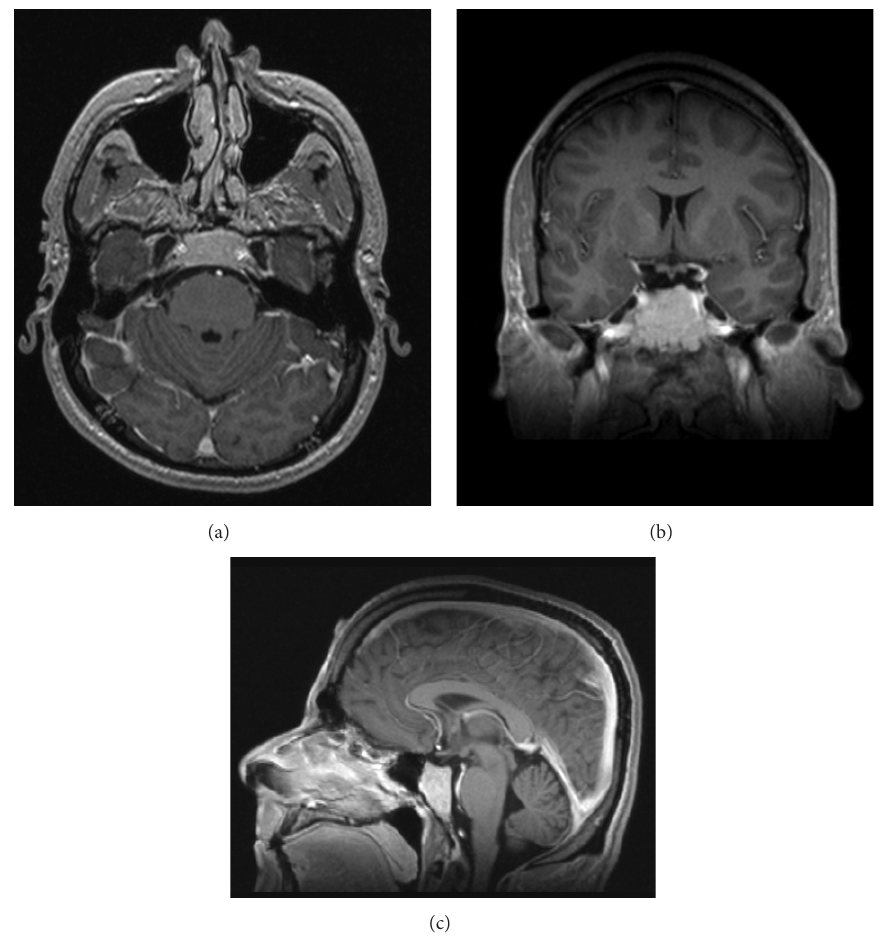
Figure 2: Preoperative magnetic resonance imaging, with contrast, axial (a), coronal (b), and sagittal (c) sections, demonstrating contrast enhancing, clival tumor.